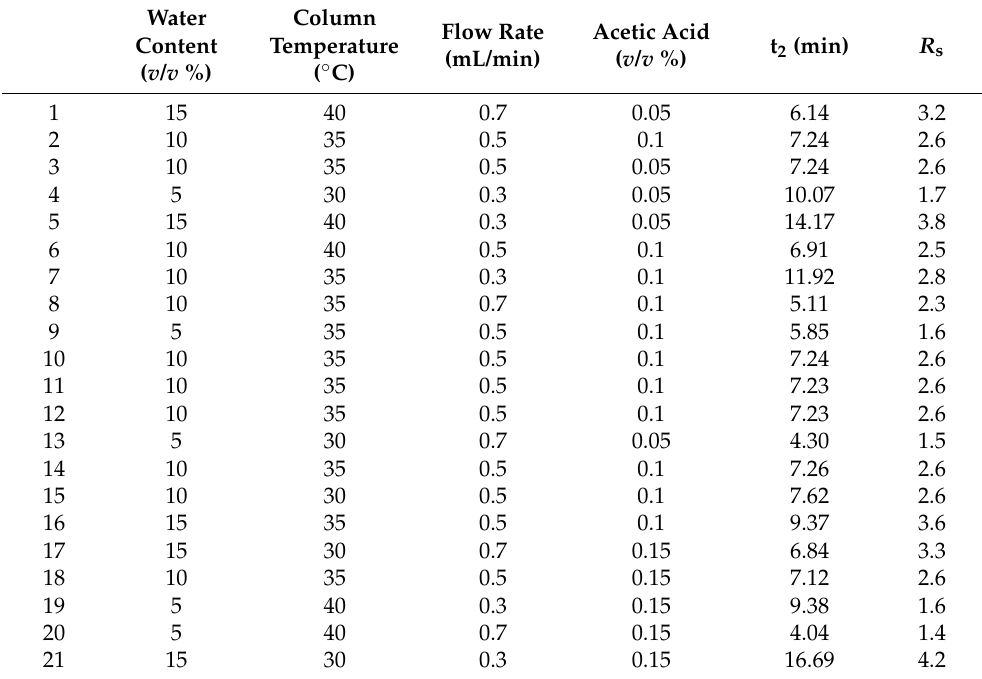
Table 2. Experimental design plan with the obtained results for the selected responses. Water